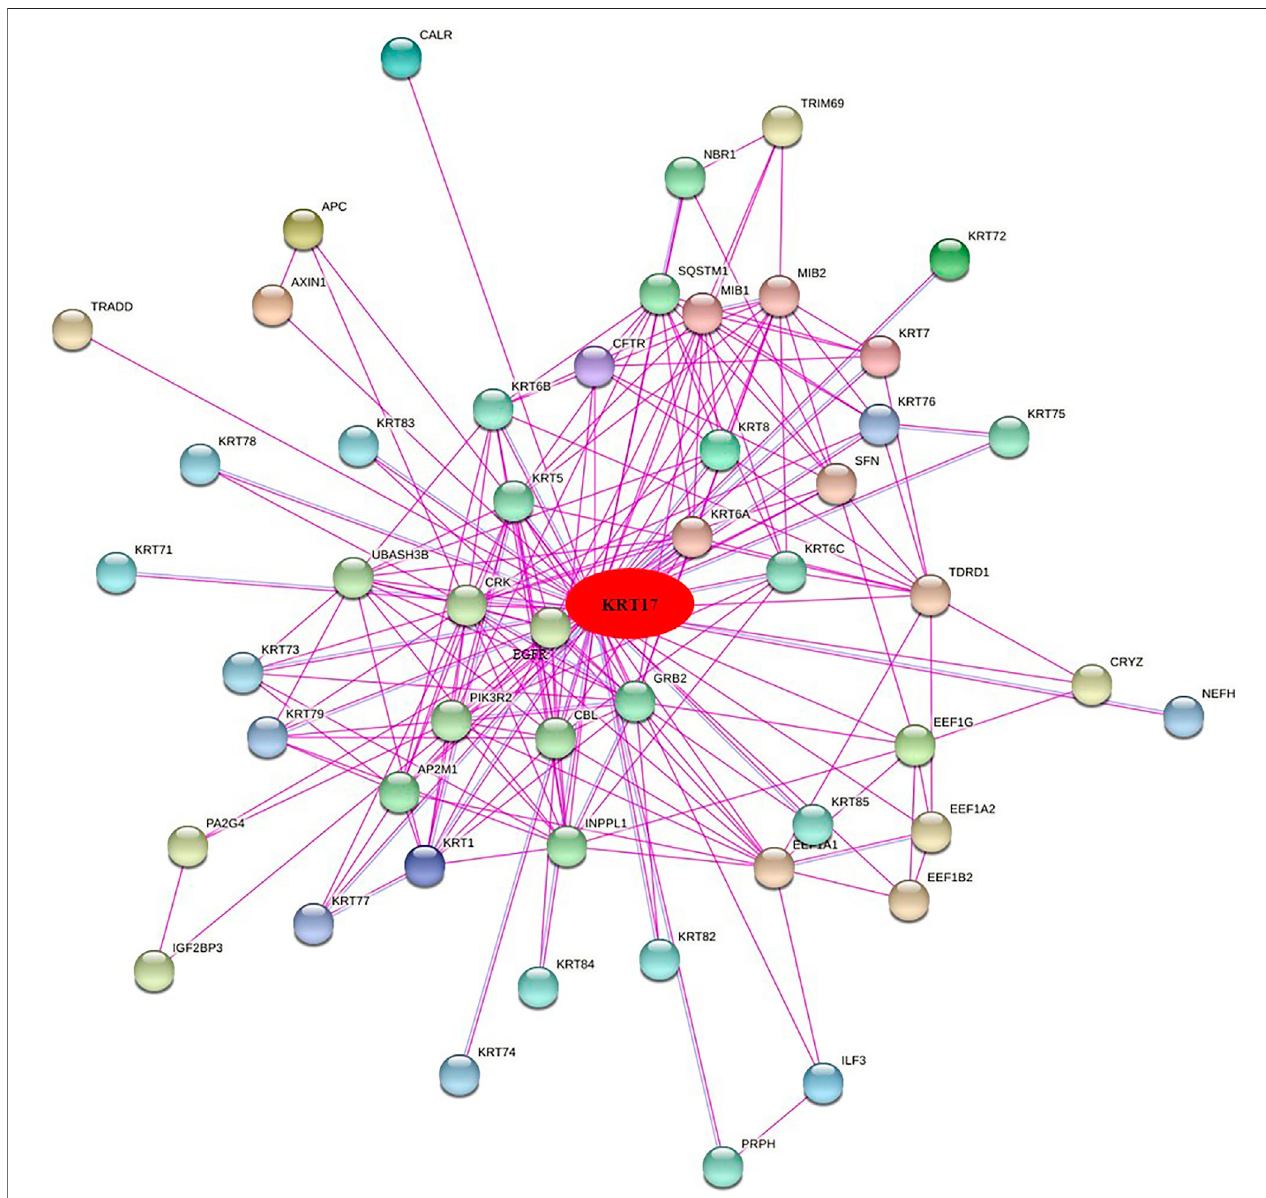
FIGURE 11 | Fifty experiments con fi rmed the binding proteins interacting with KRT17 and their interaction